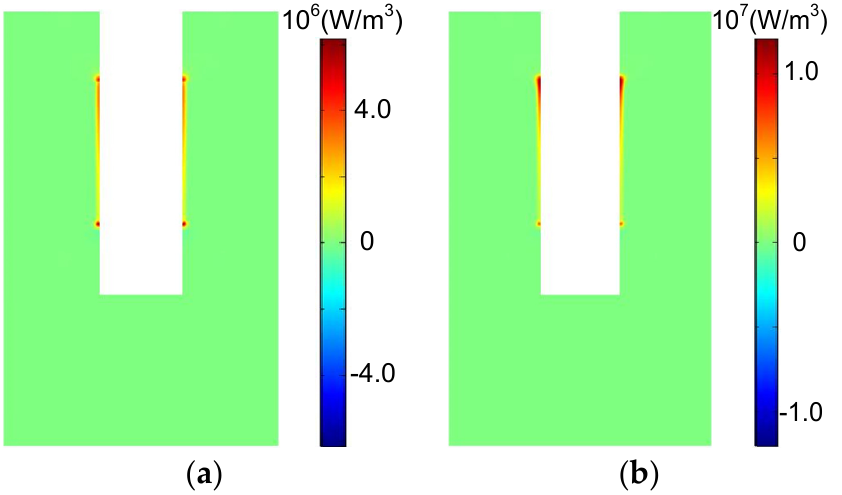
Figure 9. Distributions of power generated in the on–state device: ( a ) V DS = 3 V, V GS = 4 V; ( b ) V DS = 5 V, V GS = 4 V.